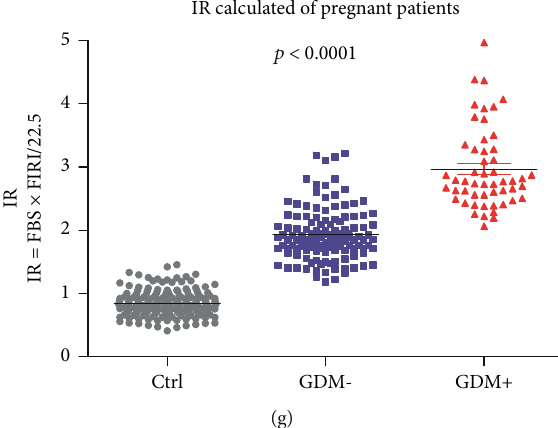
Figure 2: Blood glucose level and its relation with H S concentration and hypoglycemia in newborns. (a) Blood glucose was elevated among 2 pregnant women in the control, GDM-, and GDM+ groups. (b) The 1-hour blood glucose in newborns showed no di ff erences among the control, GDM-, and GDM+ groups. (c) The ratio of hypoglycemia in newborns, 2/185, 10/115, and 10/42, showed great di ff erences. (d) Comparison of blood glucose concentrations in pregnant women and 1-hour-old newborns. With the increase of blood glucose level, the 1-hour blood glucose of newborns was downregulated, and elevated blood glucose seems to be a leading factor for hypoglycemia. (e) Among these 3 groups, the elevated glucose in pregnant women was related to the decreased expression of H S. (f) In newborns, the 2 decreased H S concentration seems an inducement of the ratio of hypoglycemia in newborns. (g) With the increase of hyperglycemia, the 2 level of IR was upregulated in GDM-/+ pregnant (Figure 5(b), r 2 = 0 : 5342 , p = 0 : 02 ), but H S was negatively 2 correlated with IL-6 and glucose (Figure 5(d), r 2 = 0 : 509 , p < 0 : 001 , and Figure 5(f), r 2 = 0 : 1217 , p < 0 : 001 ).